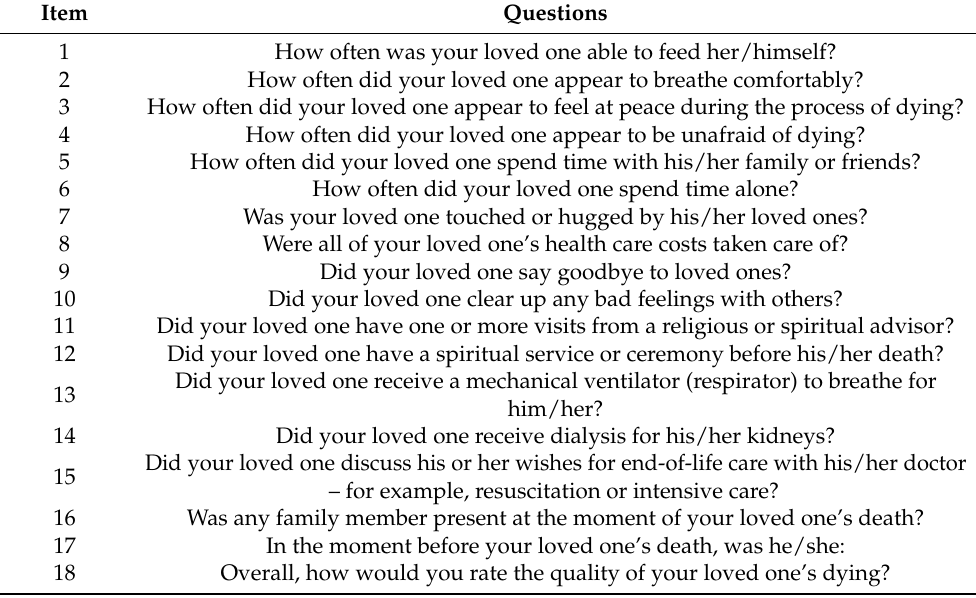
Table 5. Questions on final version of instrument validated for Brazilian